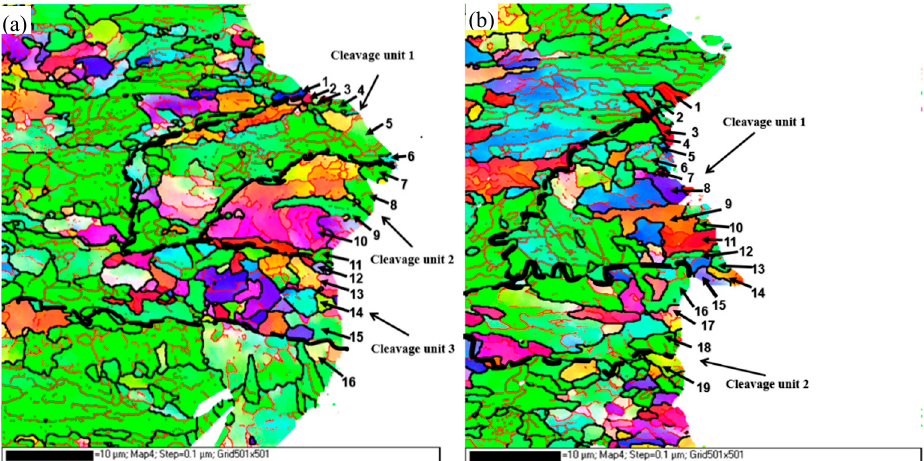
Figure 11. Schematic diagram of the fracture propagation of Charpy impact and DWTT samples: ( a ) Charpy impact, ( b ) DWTT. Table 3. Statistics of the crystal orientation relationship between Charpy impact and DWTT samples: Charpy impact corresponding to Figure 11a,b DWTT corresponding to Figure 11b.